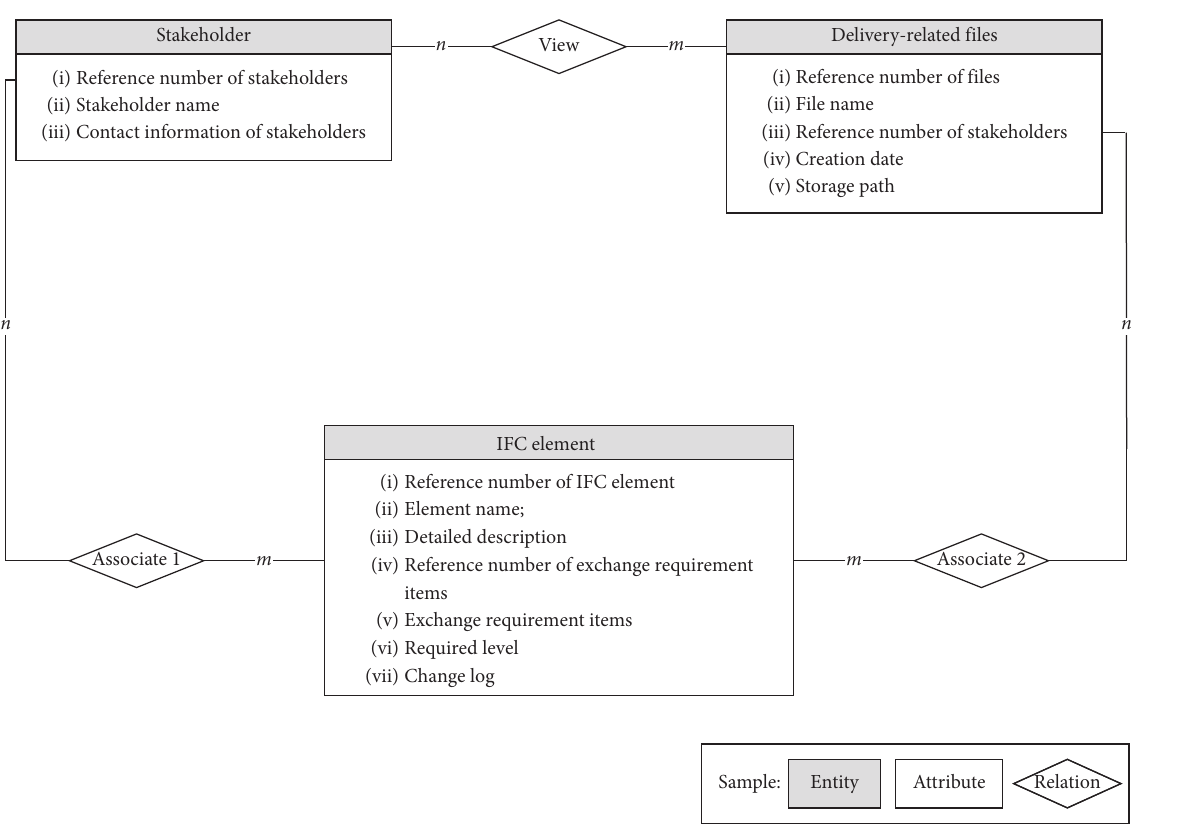
Figure 14: Entity-relationship diagram for delivery database. Table 8: Relational tables of the